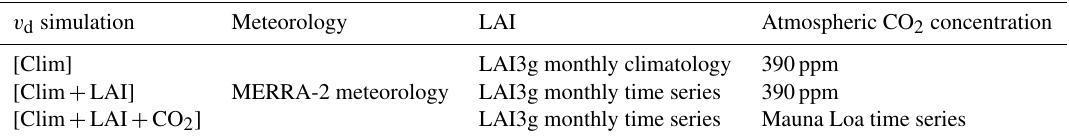
Table 1. List of v d simulations with input